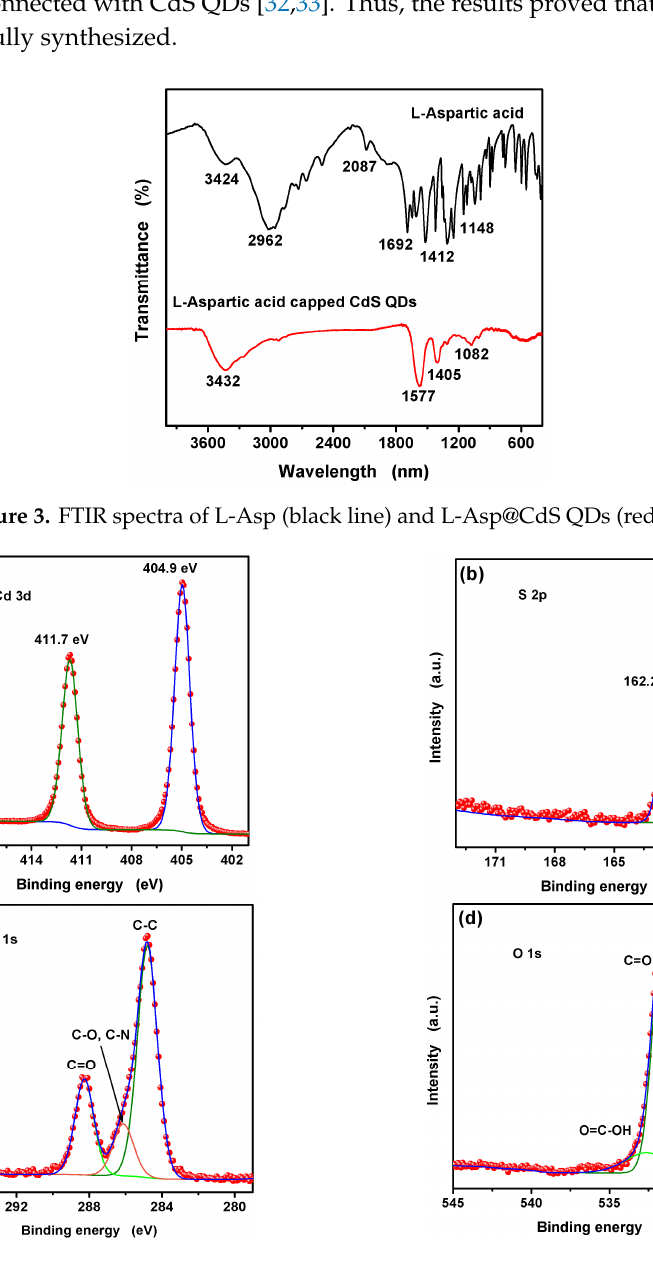
Figure 4. X-ray photoelectron spectroscopy (XPS) spectra of the synthesized L-Asp@CdS QDs: ( a ) Cd 3d spectrum, ( b ) S 2p spectrum, ( c ) C 1s and ( d ) O 1s spectrum, respectively.